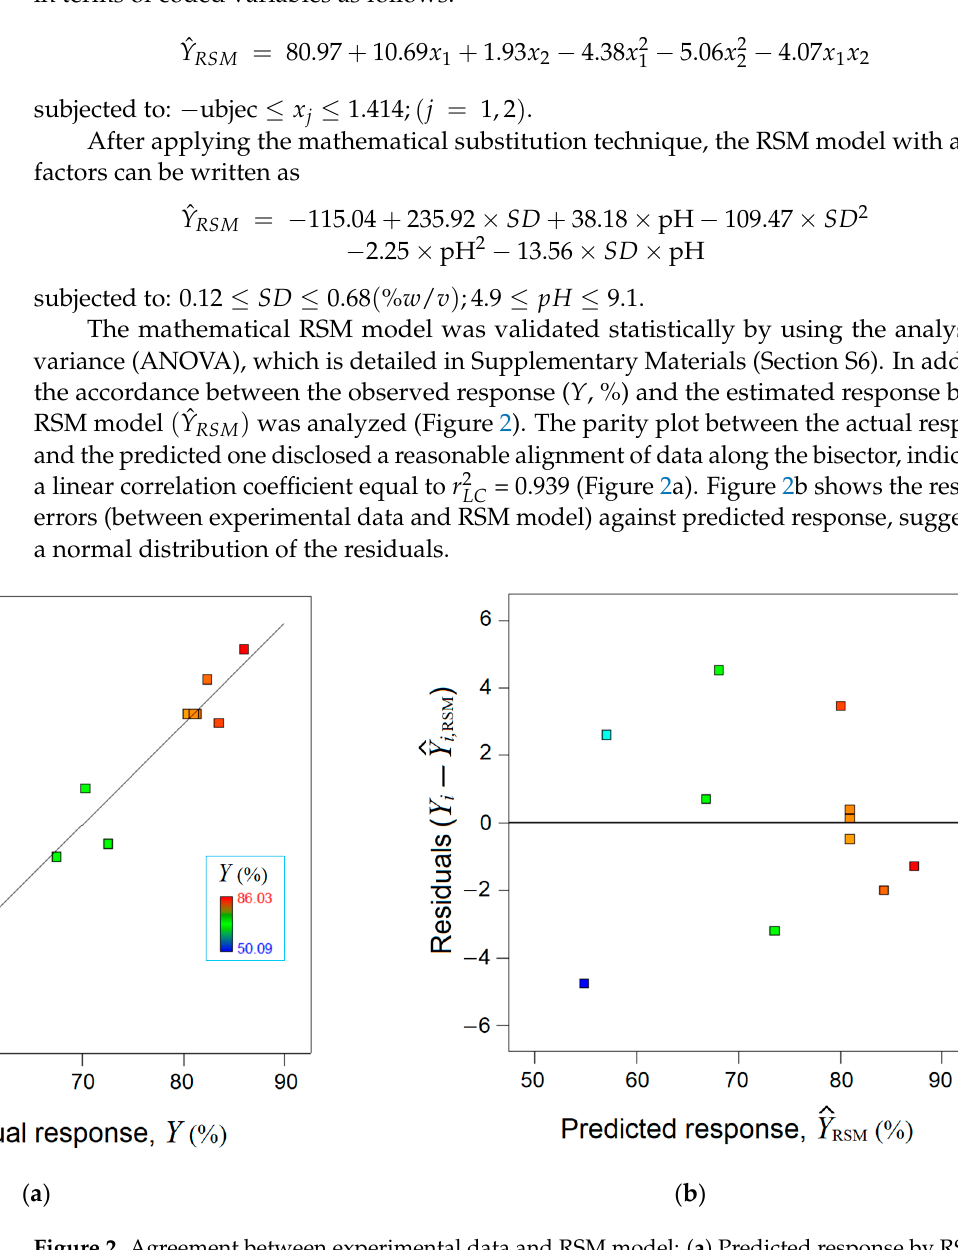
^ (cid:3019)(cid:3020)(cid:3014) ) .